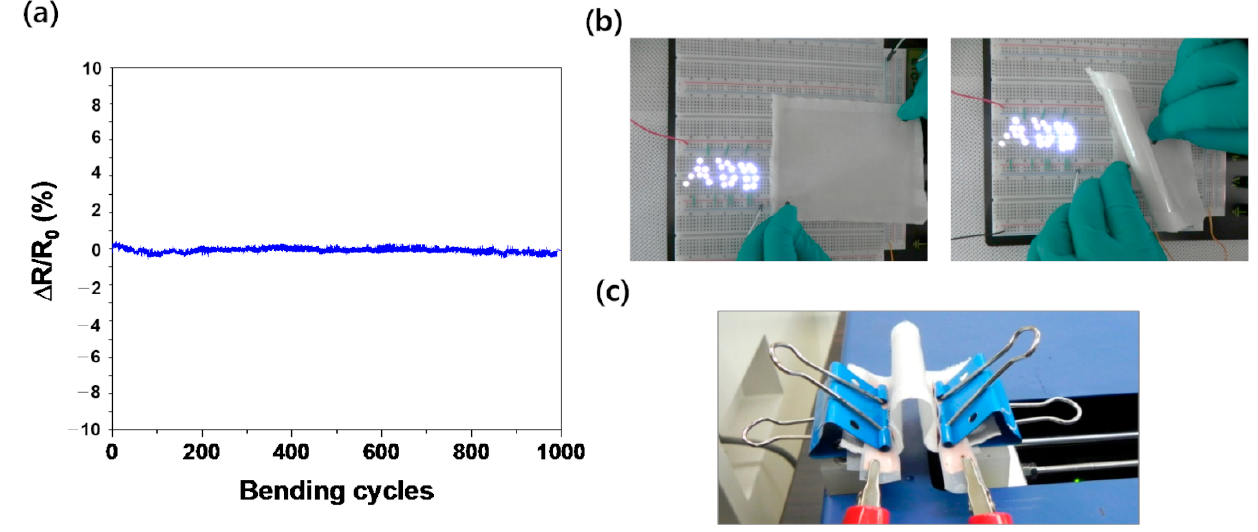
Figure 5. Mechanical stability of transferred graphene on EVA with cotton fabric, ( a ) changes in relative resistance of graphene over 1000 bending tests, ( b ) LED light on through graphene on cotton after 1000 cycles bending test, and ( c ) configuration of bending tests.